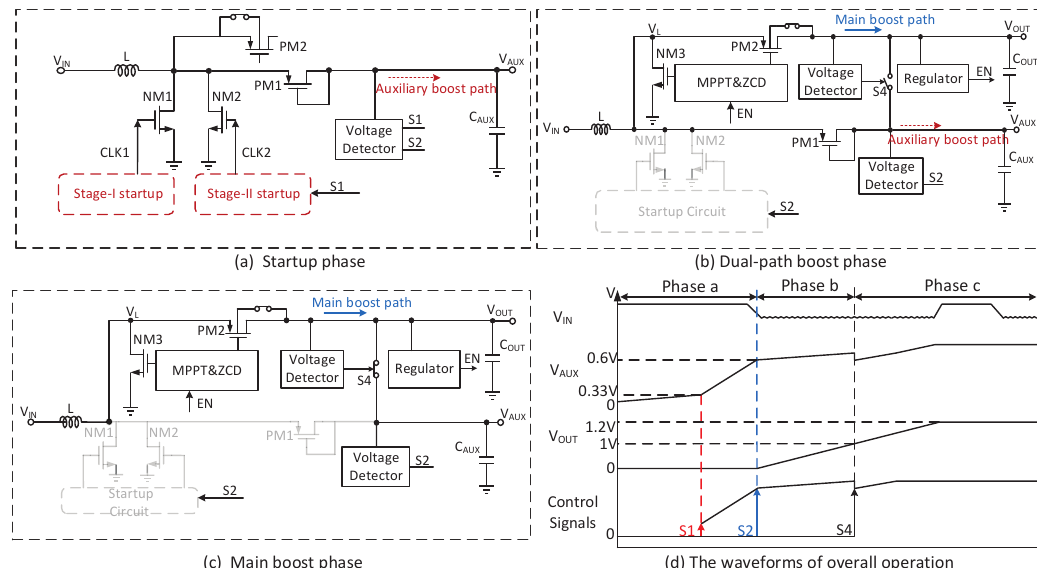
Figure 2. The three phases of the